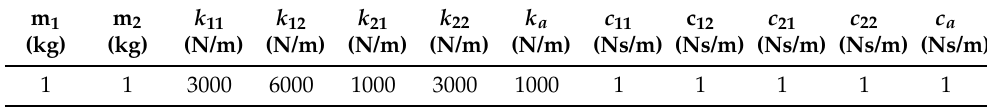
Table 1. Nominal value of the system parameters of the Double Hulten.